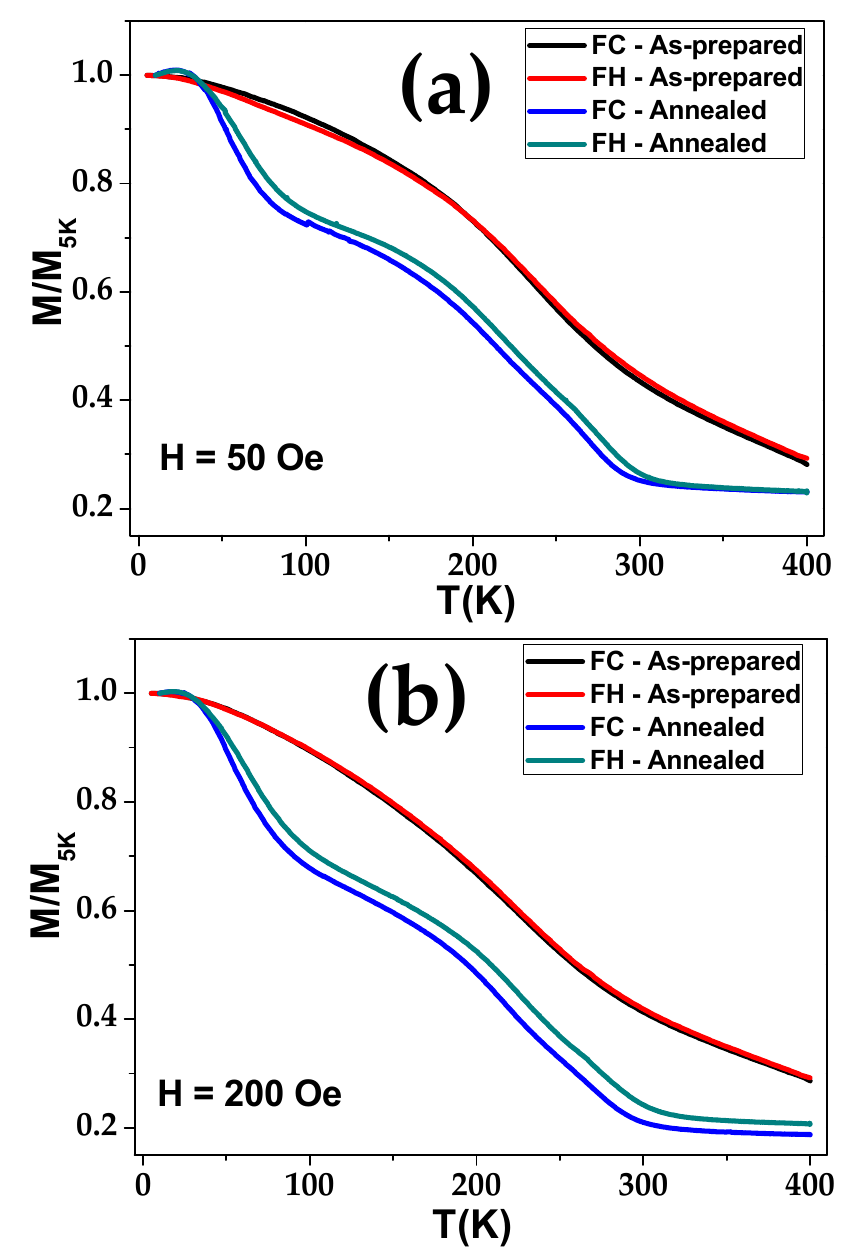
Figure 4. Temperature dependence of magnetization measured for as prepared Ni 2 FeSi glass-coated microwires with applied external magnetic field ( a ) H = 50 Oe and ( b ) H = 200 Oe. Therefore, the observed magnetic behavior, where H c , M r , FC, and FH vary